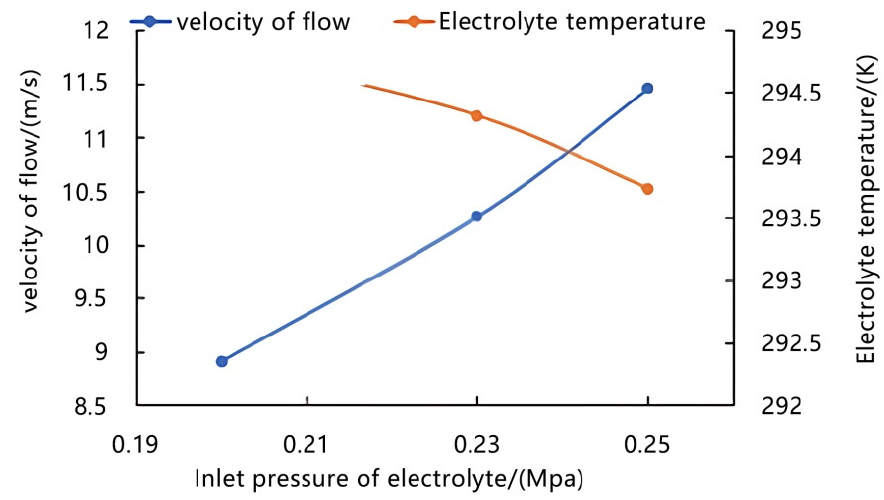
Figure 6. Variation trend of interpolar flow rate and electrolyte temperature.